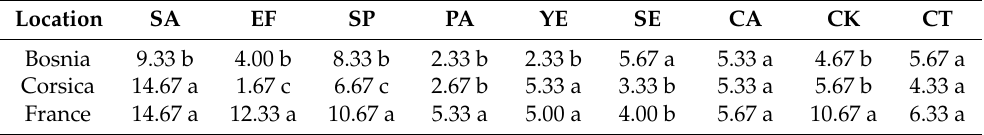
Table 8. Mean antimicrobial activities obtained from the three locations where H. italicum were collected.